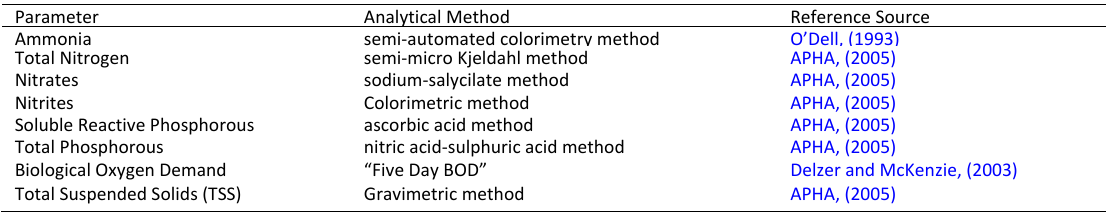
Table 1: showing data analytical methods